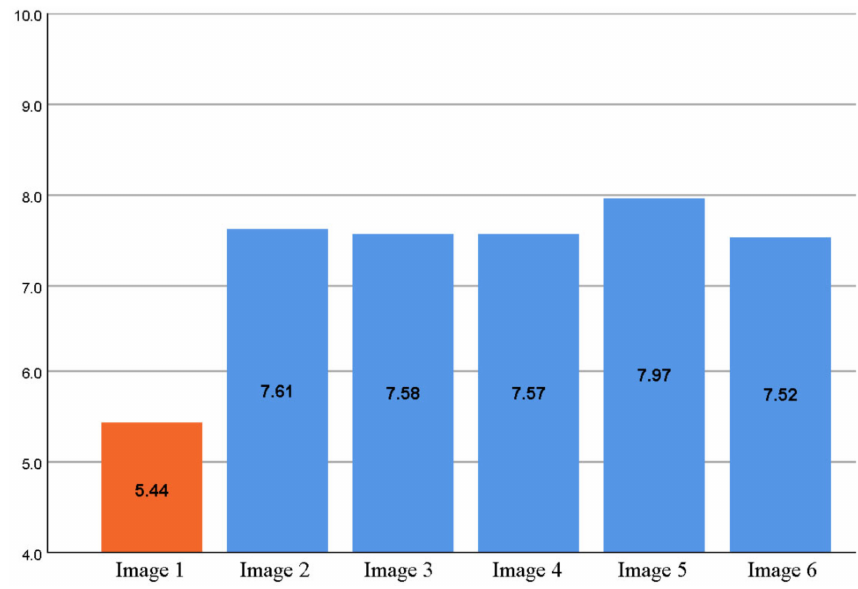
Figure 9. Residents’ attitudes towards different wooden renovation